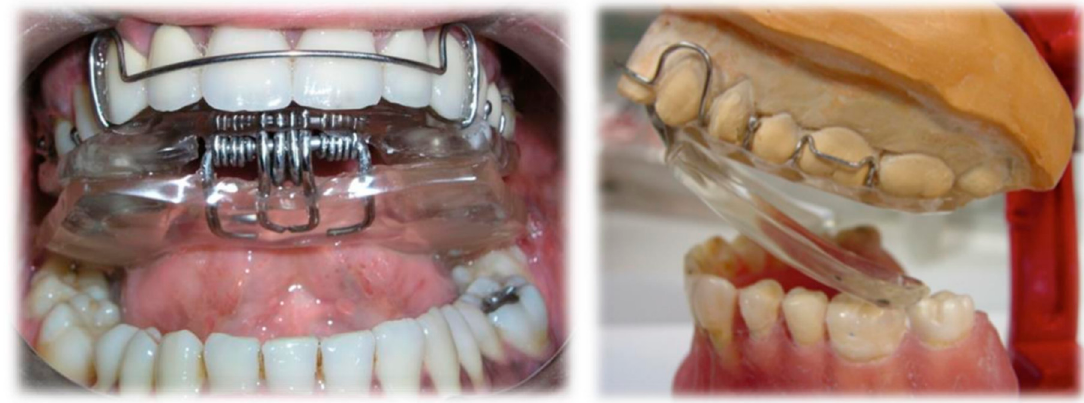
Figure 2. RA.DI.CA., mechanism of action (frontal and lateral view).